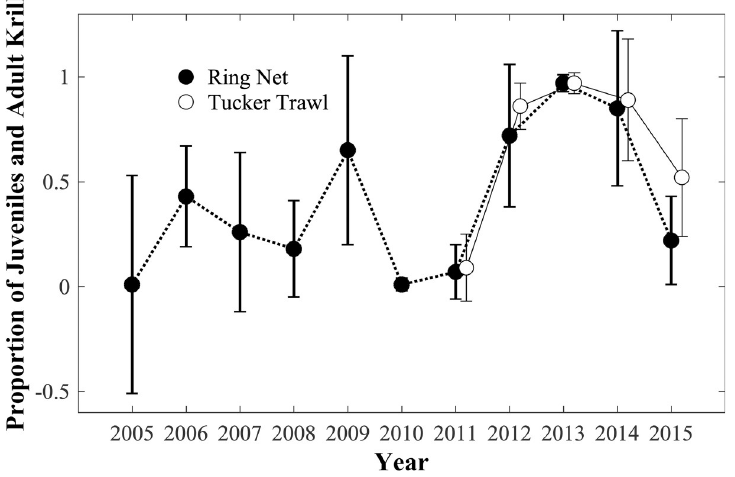
Fig 4. Annual mean proportion of Juvenile and Adult (JAD) krill of the total krill abundance. All species combined. Mean proportions for samples from both the ring net and Tucker trawl are shown. Error bars show standard